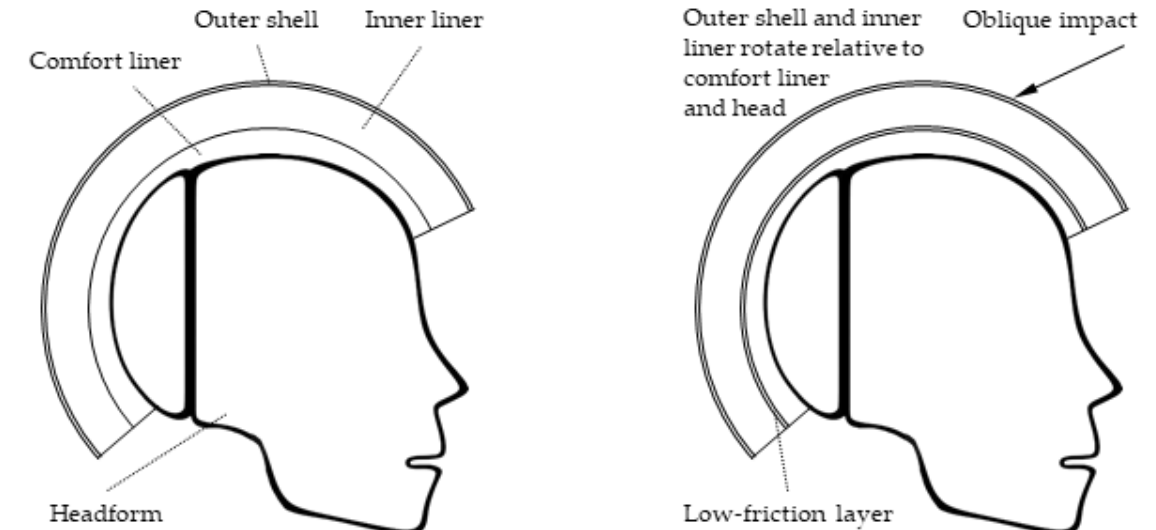
Figure 1. Cross sections of a traditional helmet ( left ) and a helmet with RDS ( right ).